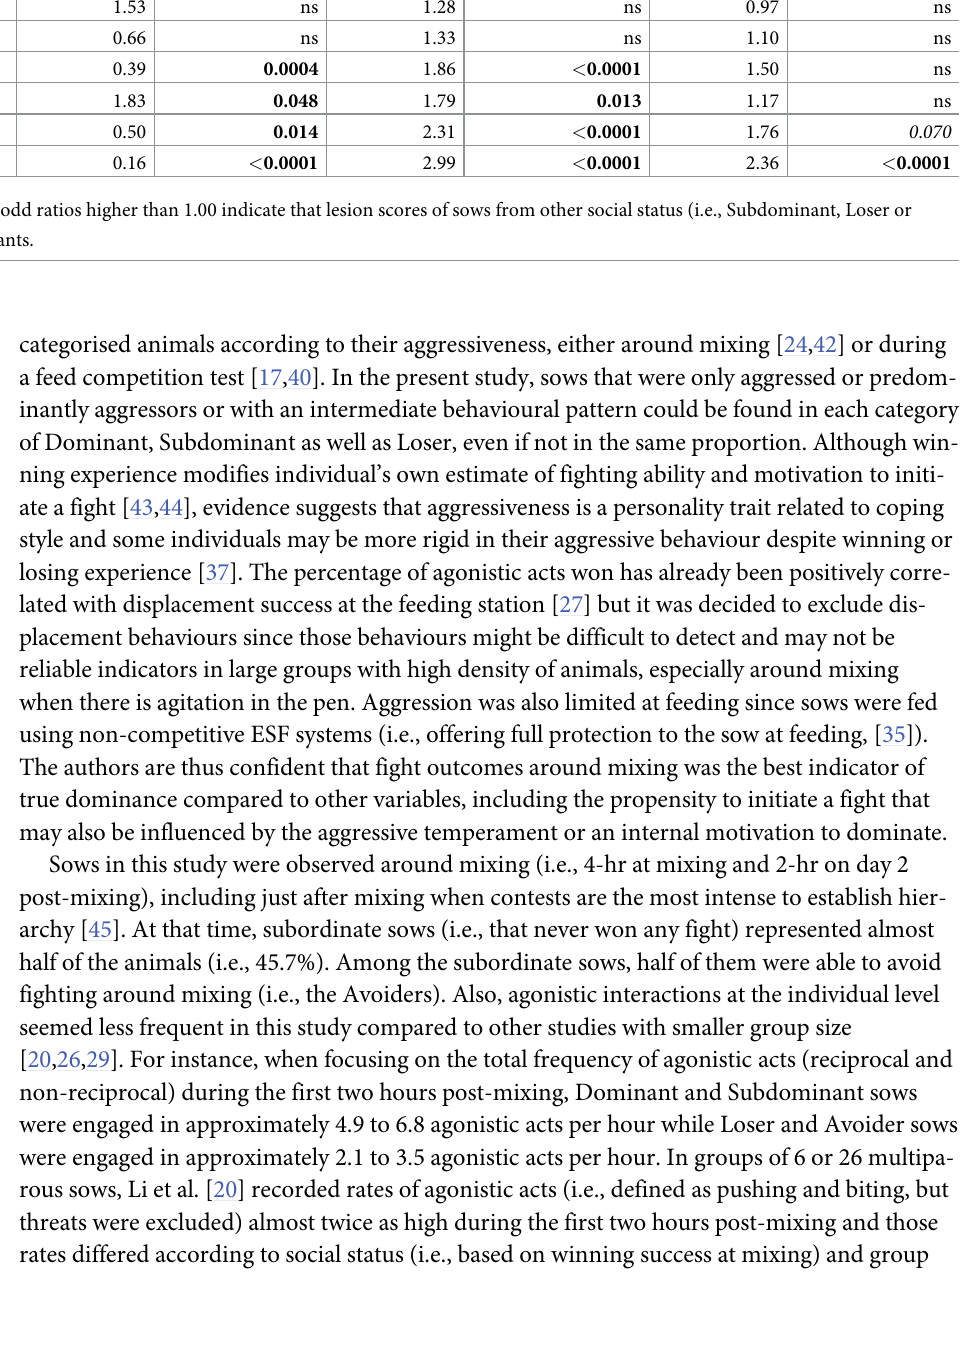
Table 3. Summary of the impact of social status on body lesion scores on each scoring day post-mixing. Body region